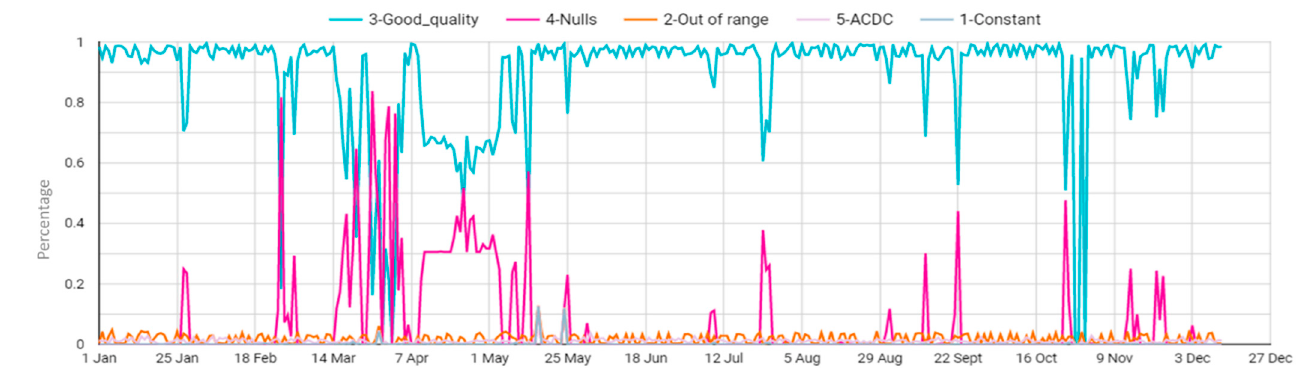
Figure 9. Data quality of the test PV plant over the evaluation period (January–December 2021).